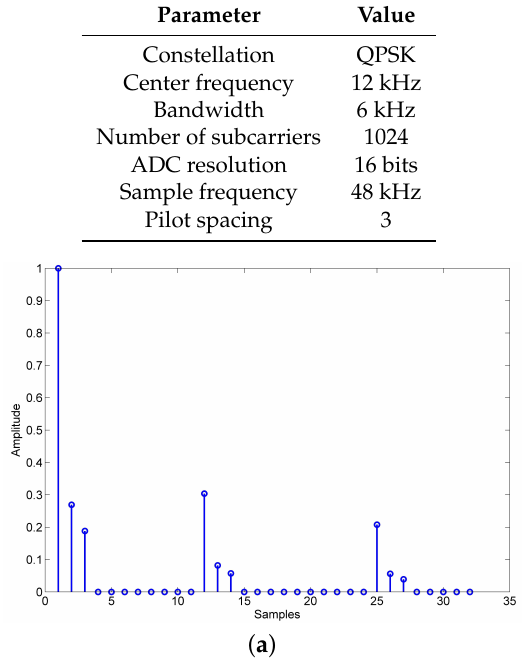
Table 1. Simulation parameters of OFDM.